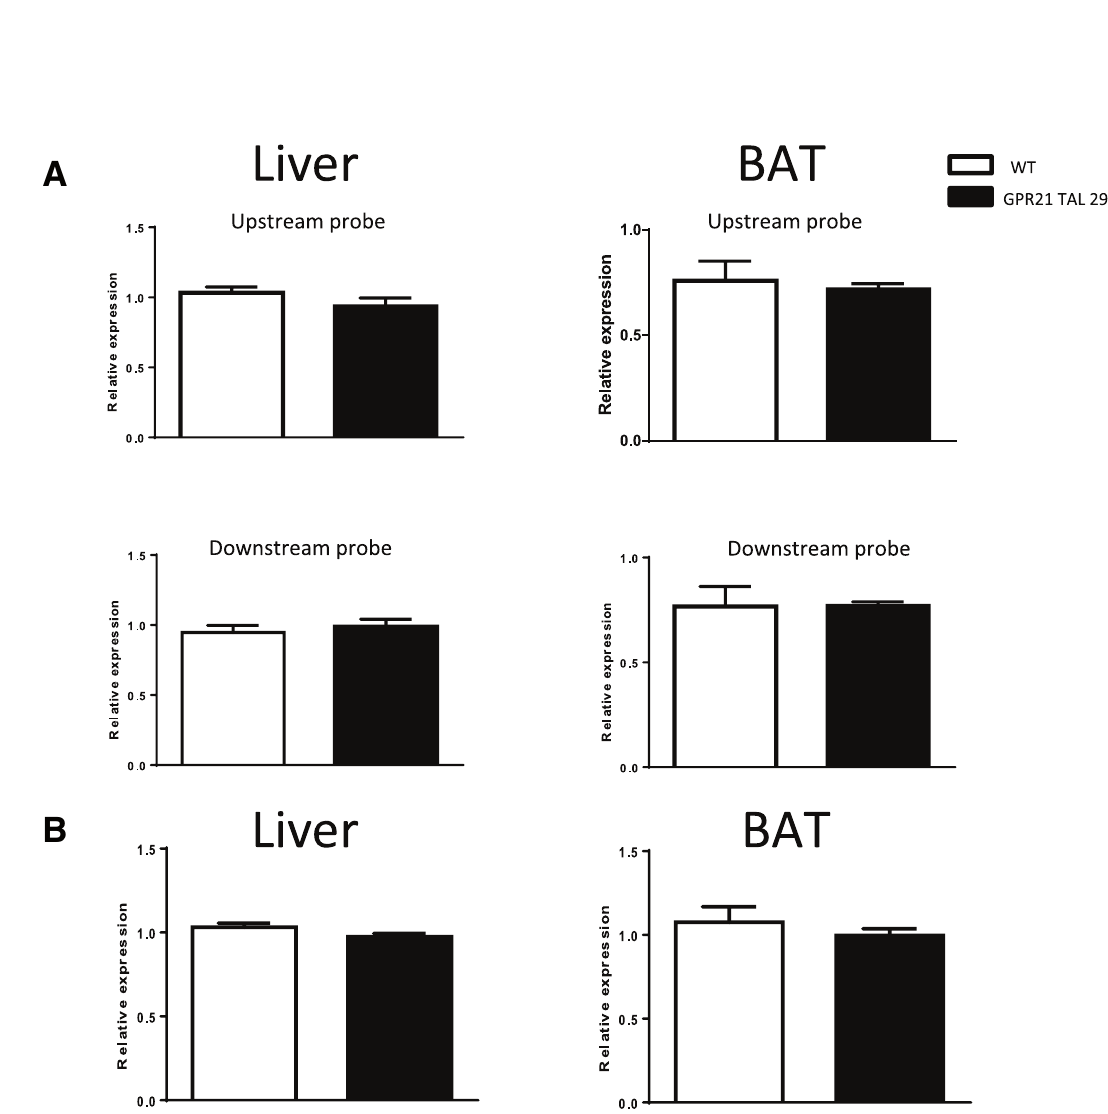
Figure 3. ( A ) Rabgap1 mRNA expression levels were assessed using 2 Taqman probes in liver (top left panel) and BAT (top right panel) of GPR21 TAL 29 bp KO and their wildtype littermate mice. ( B ) Liver (bottom left panel) and BAT (bottom right panel) strbp mRNA expression levels were assessed in wildtype and Gpr21 TAL 29bp KO